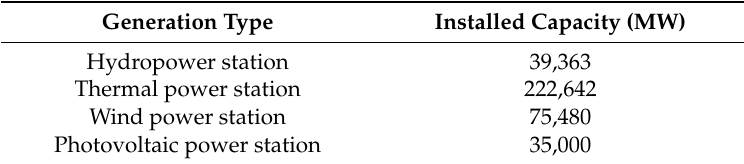
Table 1. The planning power generation capacity of the Northwest power grid.